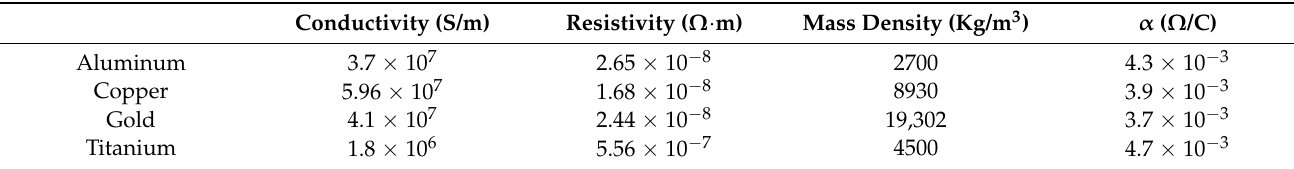
Table 1. Physical properties of biocompatible and non-magnetic